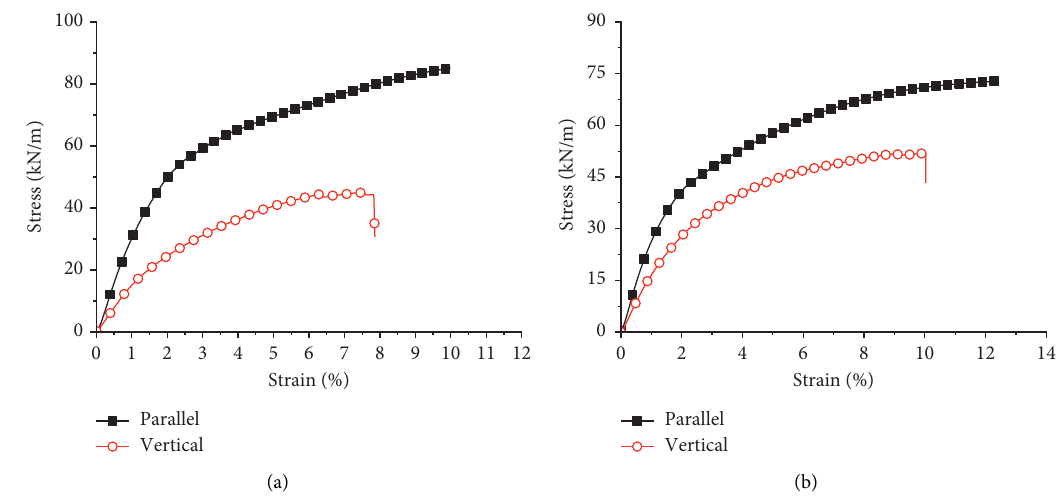
Figure 12: Tensile stress-strain curve of the square specimen. (a) Warp. (b)